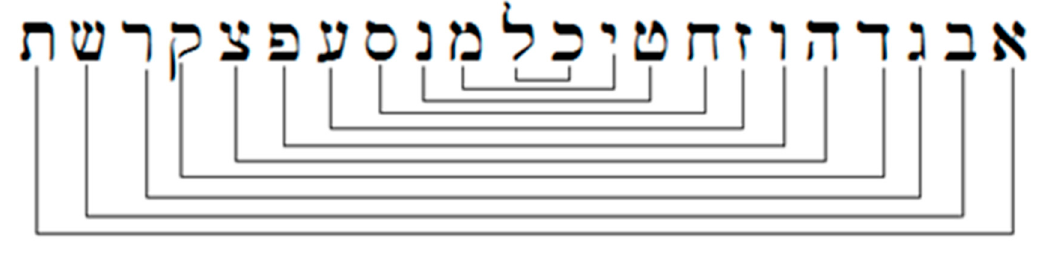
Figure 12. Hebrew alphabet showing the cryptographic substitutions of Albam